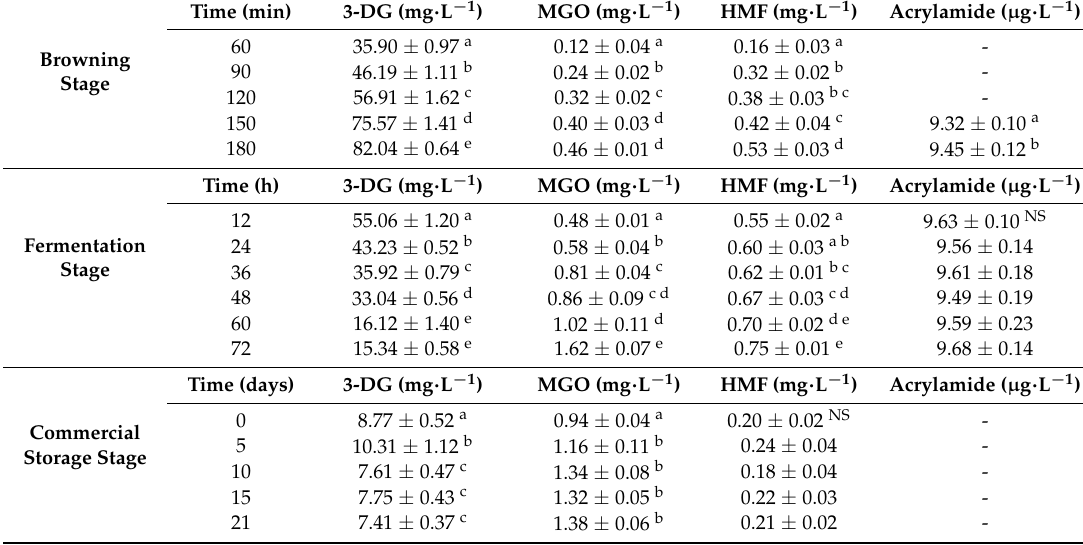
Table 1. Changes in the Maillard reaction product (MRP) levels during the manufacturing and storage of brown fermented milk